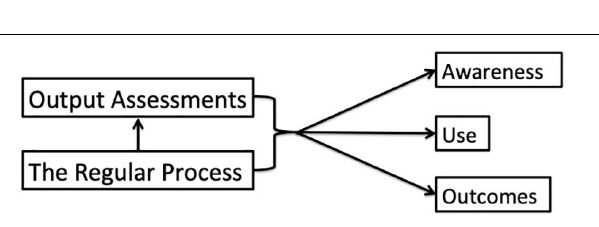
FIGURE 3 | A simplified logic model for the Regular